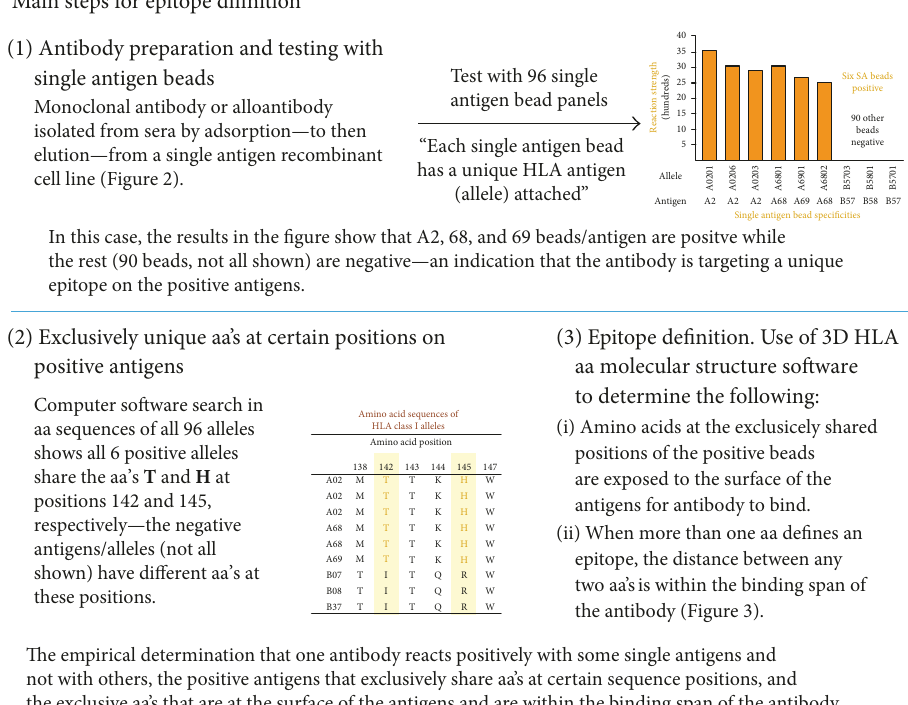
Figure 1: Main empirical testing steps to de fi ne HLA